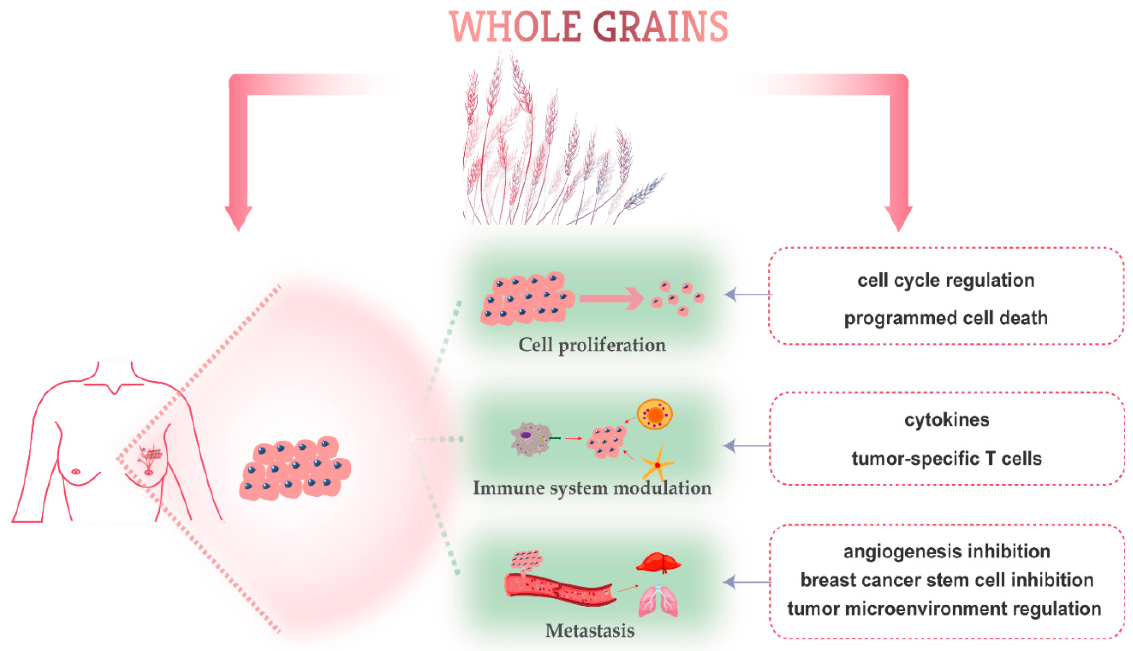
Figure 2. Schematic overview of molecular-targeted mechanisms of phytochemicals derived from whole grains against breast cancer.